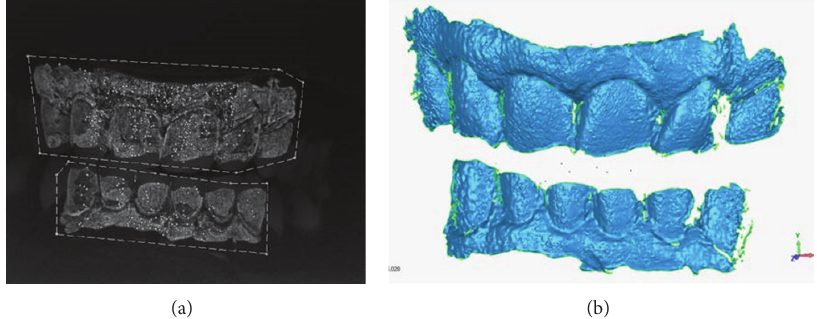
Figure 5: An example of a monochrome camera image and the associated 3D surface file. The upper and lower fluorescent regions are readily seen as well as the exposed fluorescing enamel. The white dots are part of the image alignment process used by the PhotoModeler software, and the two surrounding perimeter lines define the separate fields to be analyzed.